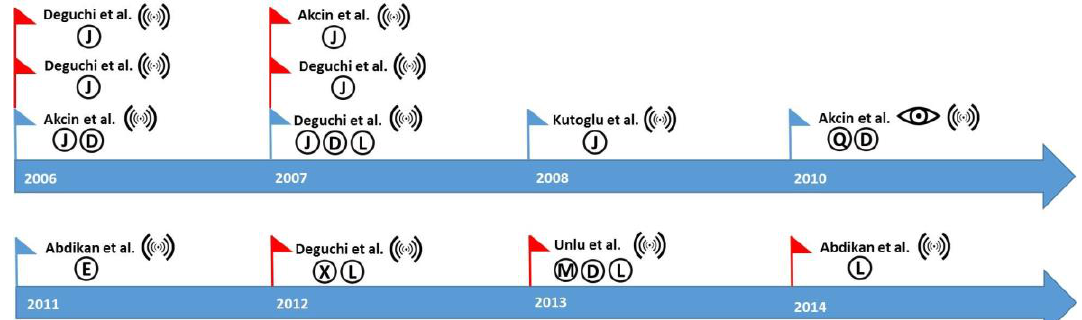
Figure 7. Summary of previous studies of deformation